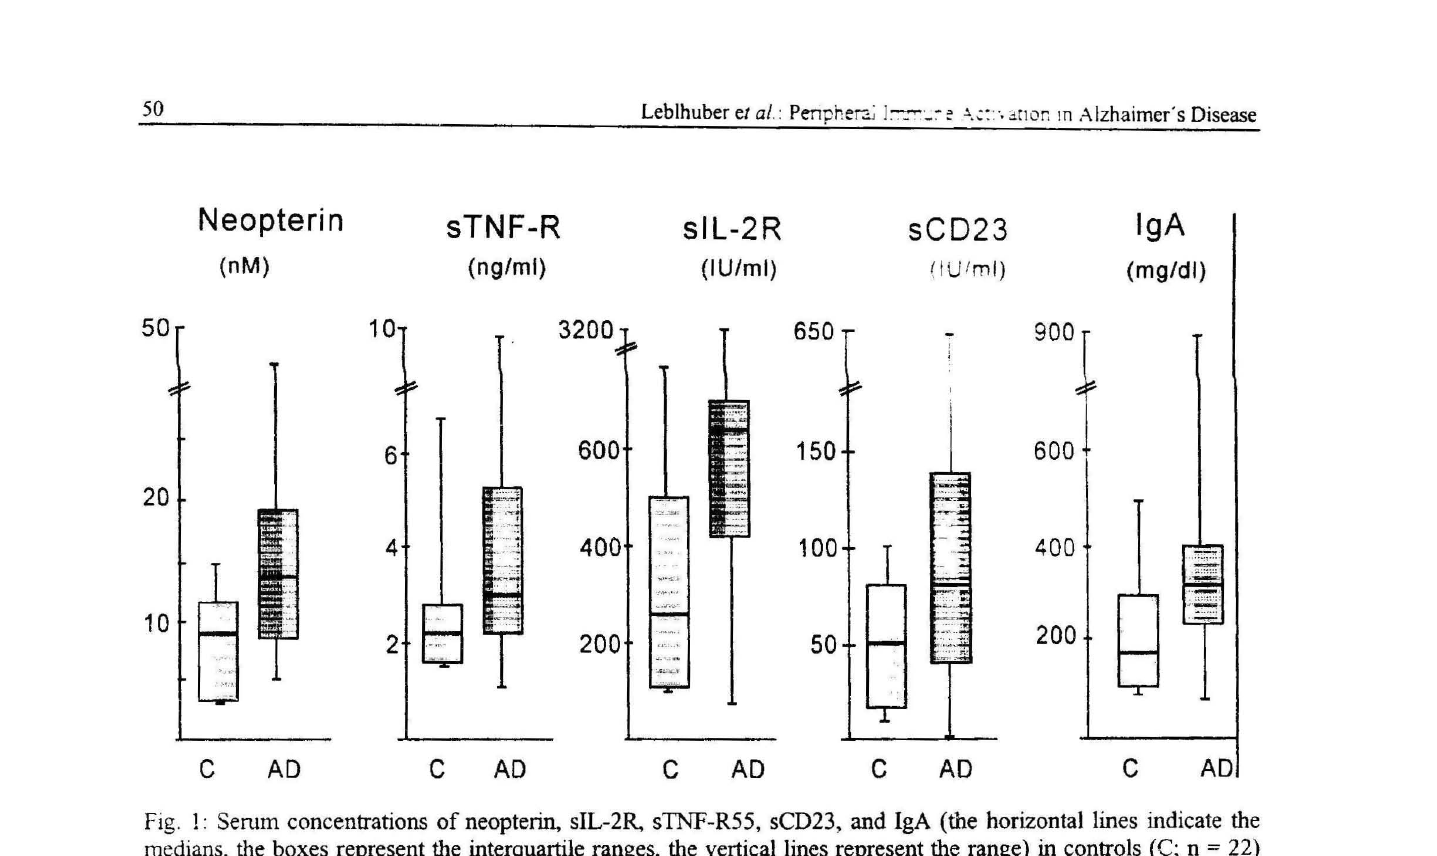
Fig. !: Serum concentrations of neopterin, sIL-2R, sTNF-R55, sCD23, and IgA (the horizontal lines indicate the medians, the boxes represent the interquartile ranges, the vertical lines represent the range) in controls (C; n = 22) and in patients with Alzheimer's disease (AD; n =